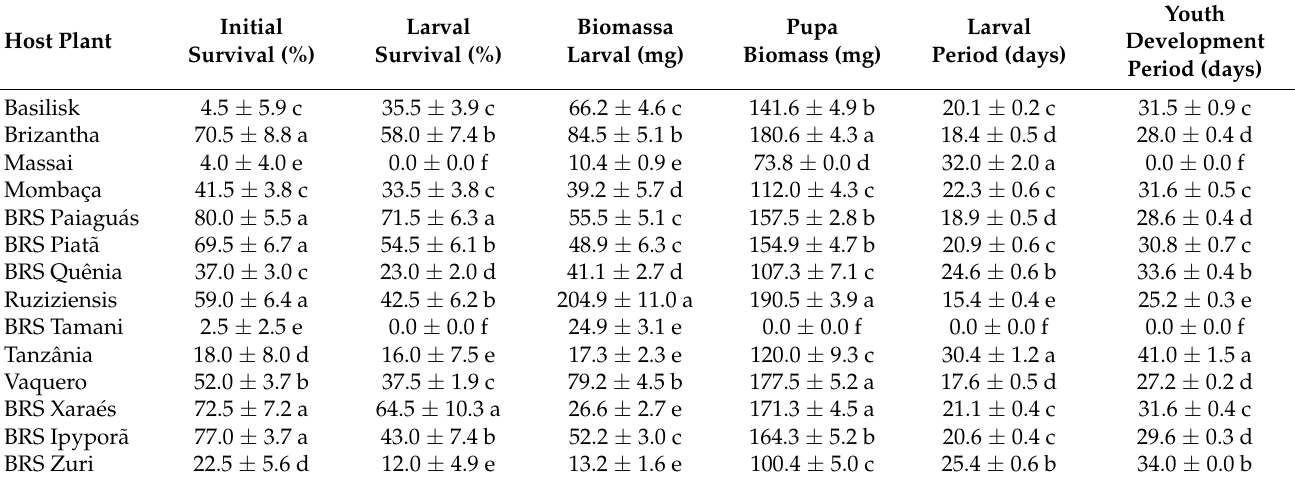
Table 2. Means ( ± SE) of biological variables of Spodoptera frugiperda larvae fed with different hosts.